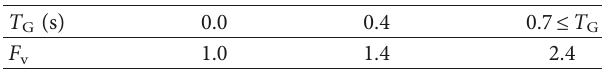
Table 6: Midperiod amplification factor according to site period